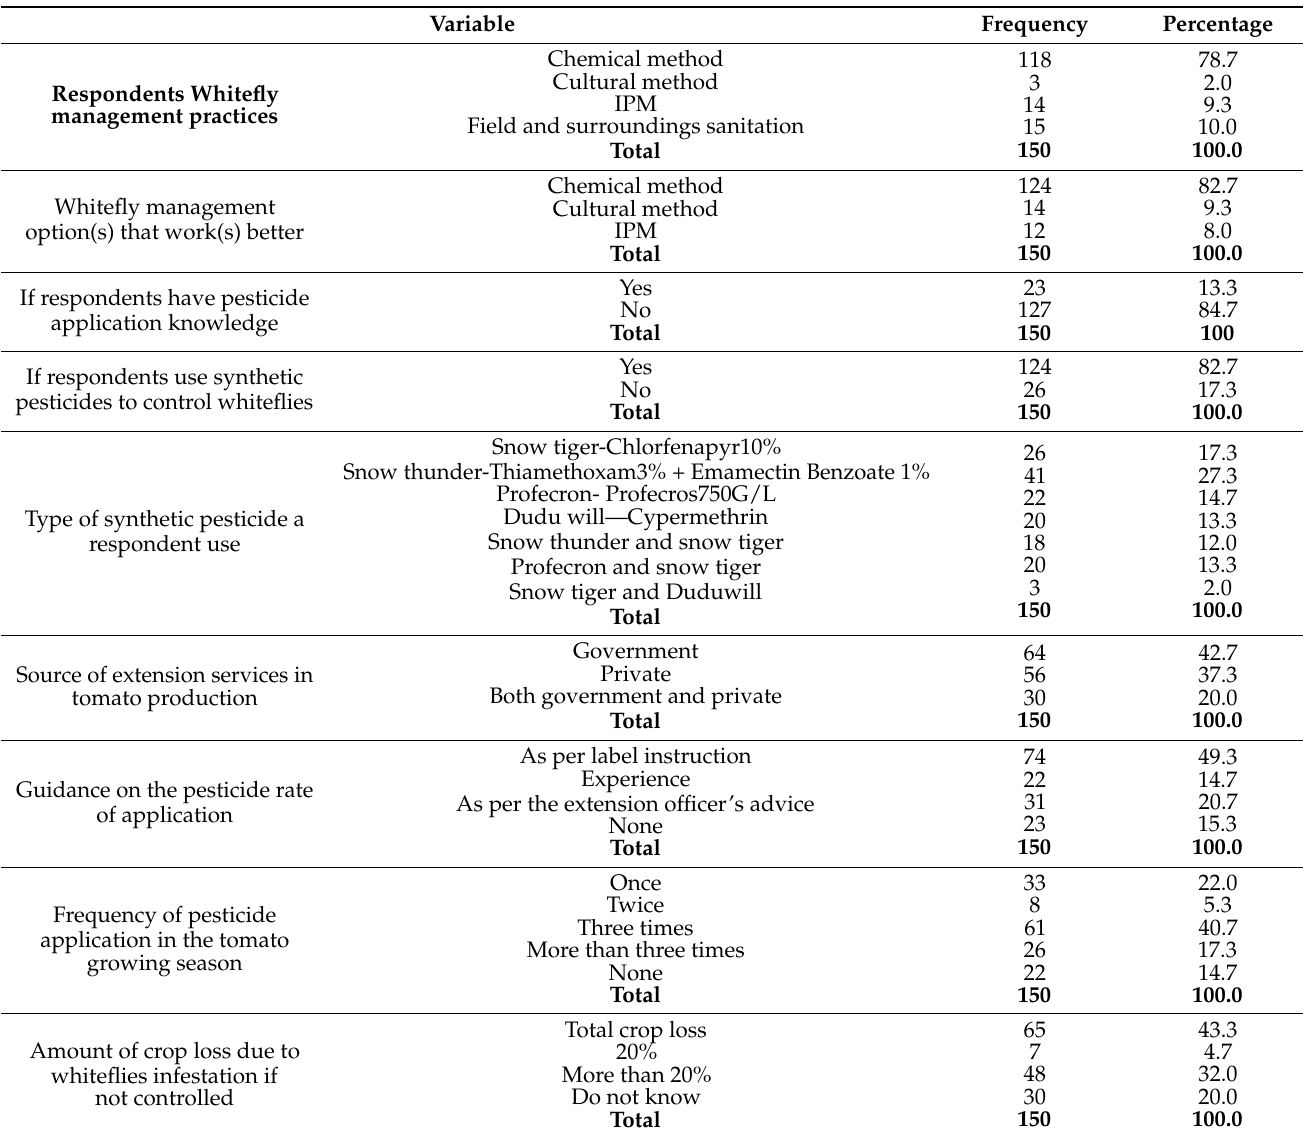
Table 4. Farmers’ perception on various aspects of whitefly management